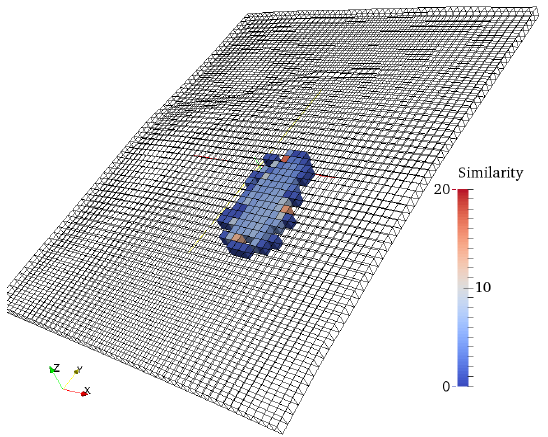
Figure 9. Spatial distribution of the self-similarity (cf. text for def- inition) of chemical reactions relative to total carbonate mineral- isation for the fully coupled reactive transport simulations in the homogeneous case.